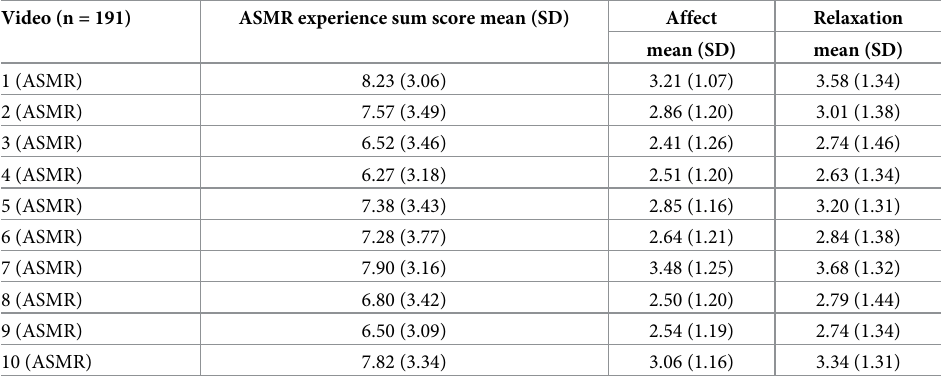
Table 4. Mean values regarding ASMR experience, affect and relaxation for the individual ASMR videos. Video (n = 191) ASMR experience sum score mean